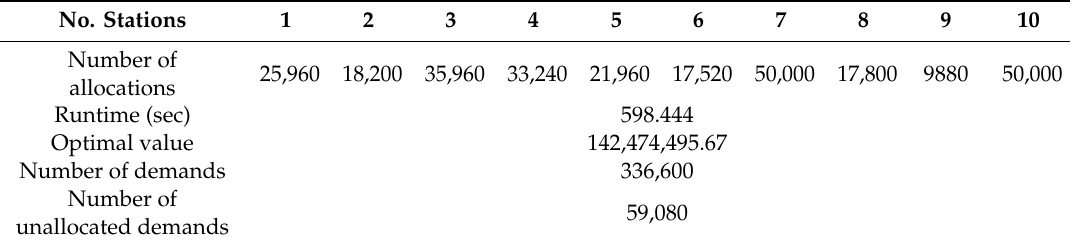
Figure 10. The allocation of each station using the Simulated Annealing algorithm in the VAOCMP model. Table 15. The number of allocations for each station, runtime, and the optimal value of the function using the Simulated Annealing algorithm in the VAOCMP model.